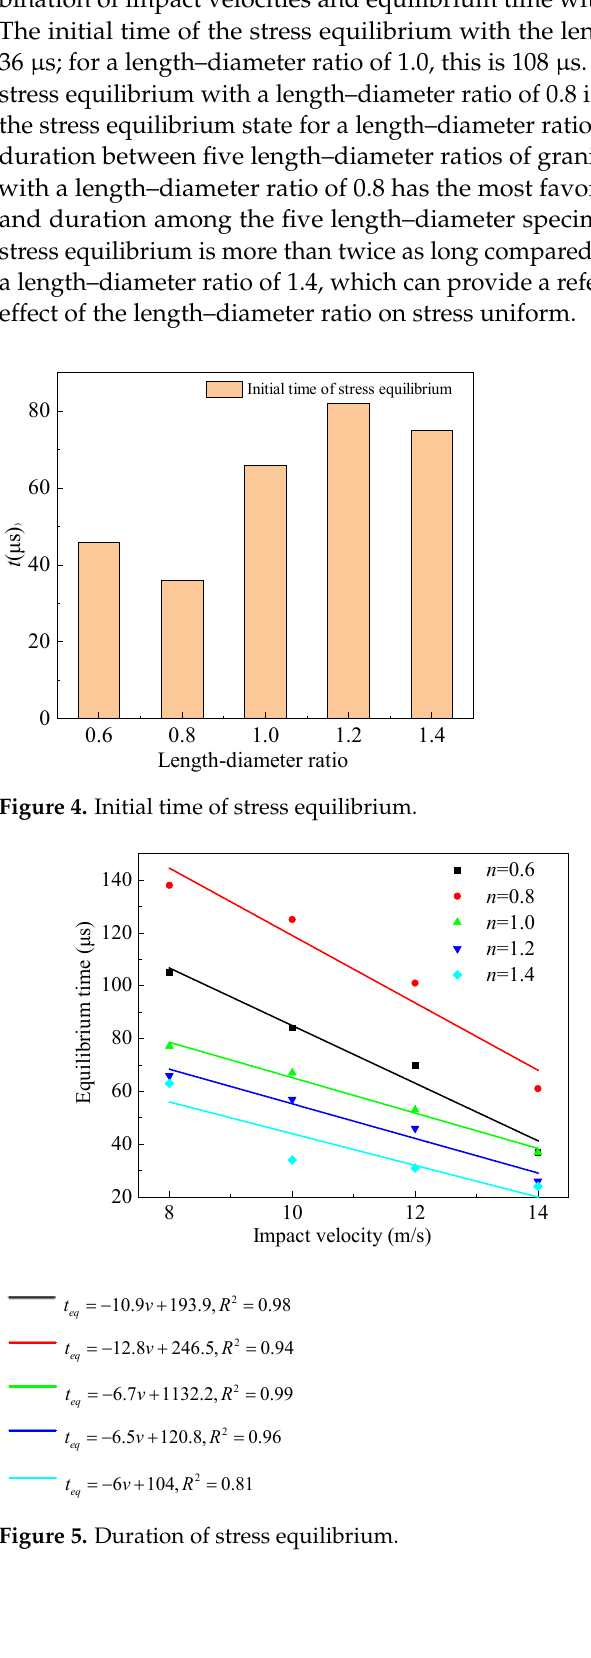
specimen is divided into three stages: stress disorder, stress equilibrium, and stress im- Figure 5. Duration of stress equilibrium. balance. With the increase of the strain rate, the emergence of stress equilibrium in the same length–diameter ratio granite specimen was postponed successively, and the dura- tion of stress equilibrium was reduced. However, the fluctuation of the granite specimen with the length–diameter ratio of 1.0 was unstable, with “W” type fluctuation. Under the same impact load, the degree of fluctuation of the stress balance factor curve shows a significant negative correlation with the length–diameter ratio. The two ends of stress balance factor curves performed dramatic fluctuations with small length– diameter ratios, but the stress equilibrium can be maintained for a longer period. Moreo- ver, the stress equilibrium factor of rocks with large length to-diameter ratio changes ab- ruptly at the beginning and end, and the duration of stress equilibrium is relatively short.